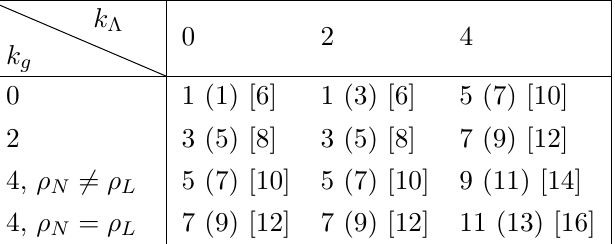
Table 2. Number of free independent real parameters in models containing modular forms of weights (cid:20) 4. For each pair ( k (cid:3) ; k g ), the (cid:12)rst number is the number of parameters in M (cid:23) apart from h (cid:28) i . The second number (in parentheses) is the number of parameters in M (cid:23) including the 2 real parameters from h (cid:28) i . The third number [in brackets] is the total number of free independent parameters contained in M (cid:23) and M e